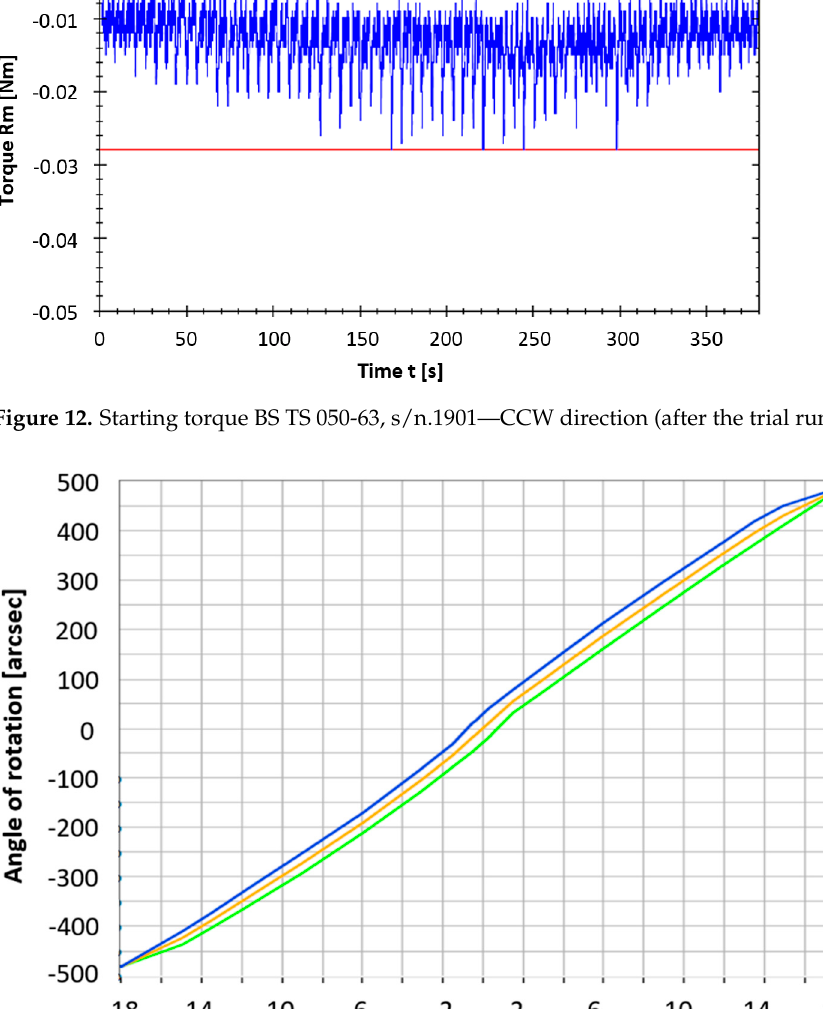
Figure 11. Starting torque BR TS 050-63, s/n.1901—CW direction (after the trial run).